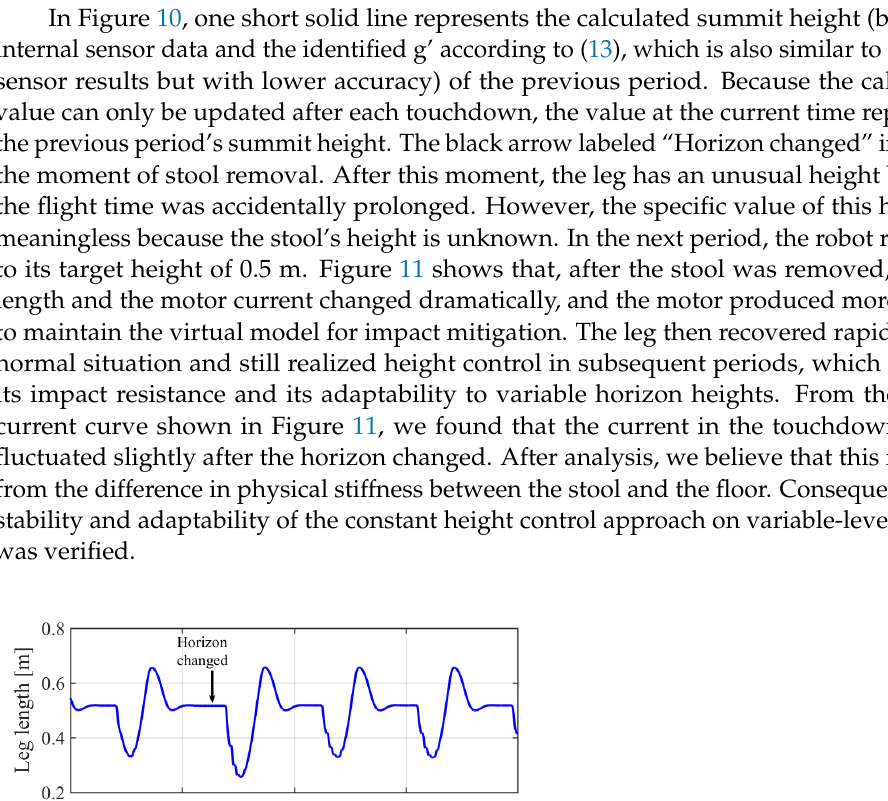
Figure 10. Summit hopping height during continuous constant height hopping. The black dashed line is the set target summit height; orange short solid lines represent actual calculated heights based on the measured hang times. At the initial moment, the measured value is zero because the leg’s summit height cannot be calculated before the first touchdown.